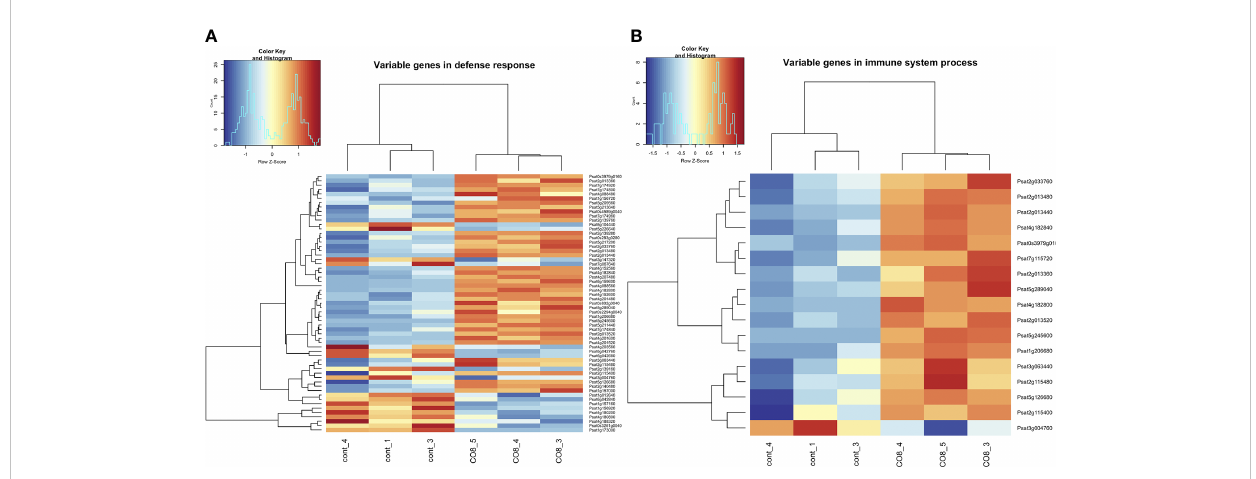
FIGURE 2 Heatmap of gene expression levels after CO8-DA treatment (3 biological replicas) in comparison to control (Jensen ’ s medium) (3 biological replicas). The list of genes that changed expression levels and were annotated in Gene Ontology terms as a part of “ defense response ” (A) and “ immune system process ” (B) biological processes in pea roots 24 h after